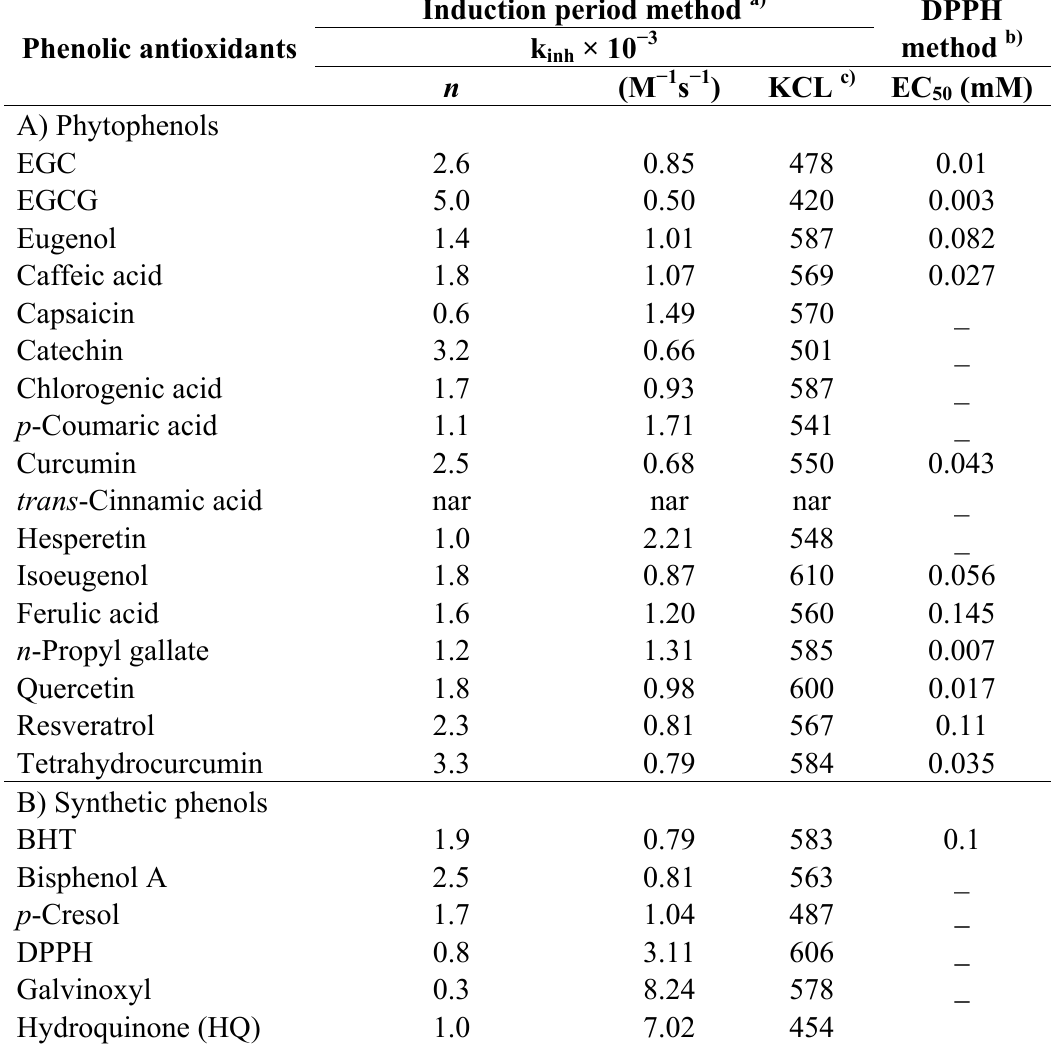
Table 1. Radical-scavenging activity for dietary phutophenols and synthetic phenols using induction